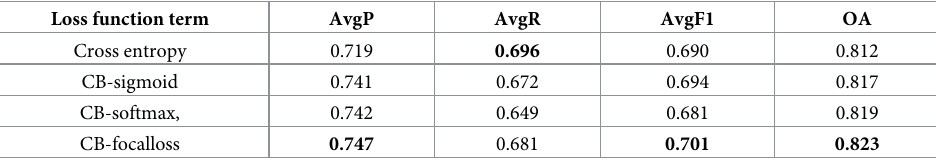
Table 2. The comparison on different loss function